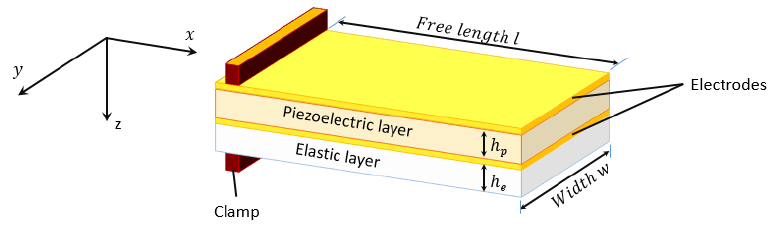
Figure 1. Layer sequence of a